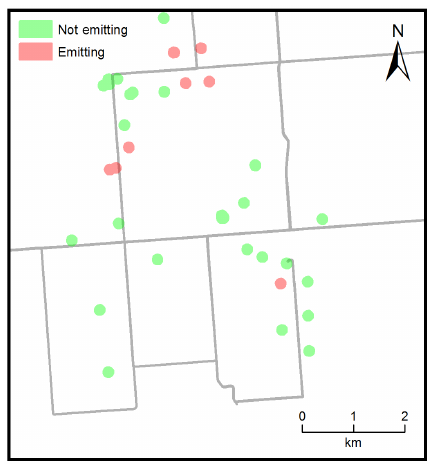
Figure 5. A subset of infrastructure locations that we surveyed dur- ing our field campaign in attributed form. This figure serves as an example of how we attributed wells and processing facilities to on- road plumes. Grey lines represent the survey route. In this case 31 wells or facilities were surveyed, and we used our attribution tech- nique, which accounts for wind direction and distance to source, to determine whether or not these wells and processing facilities were probable emission